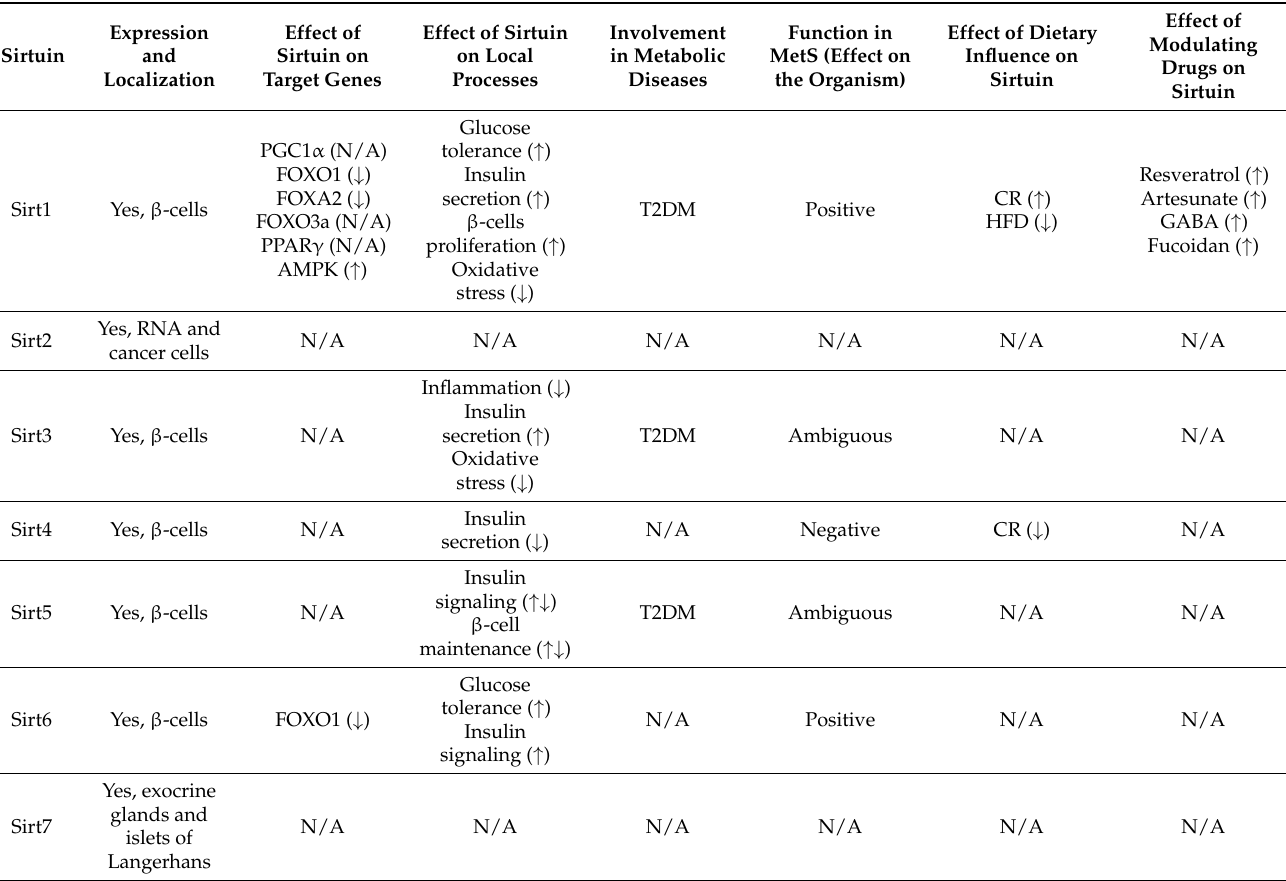
Table 1. Overview of the role of Sirtuins in the